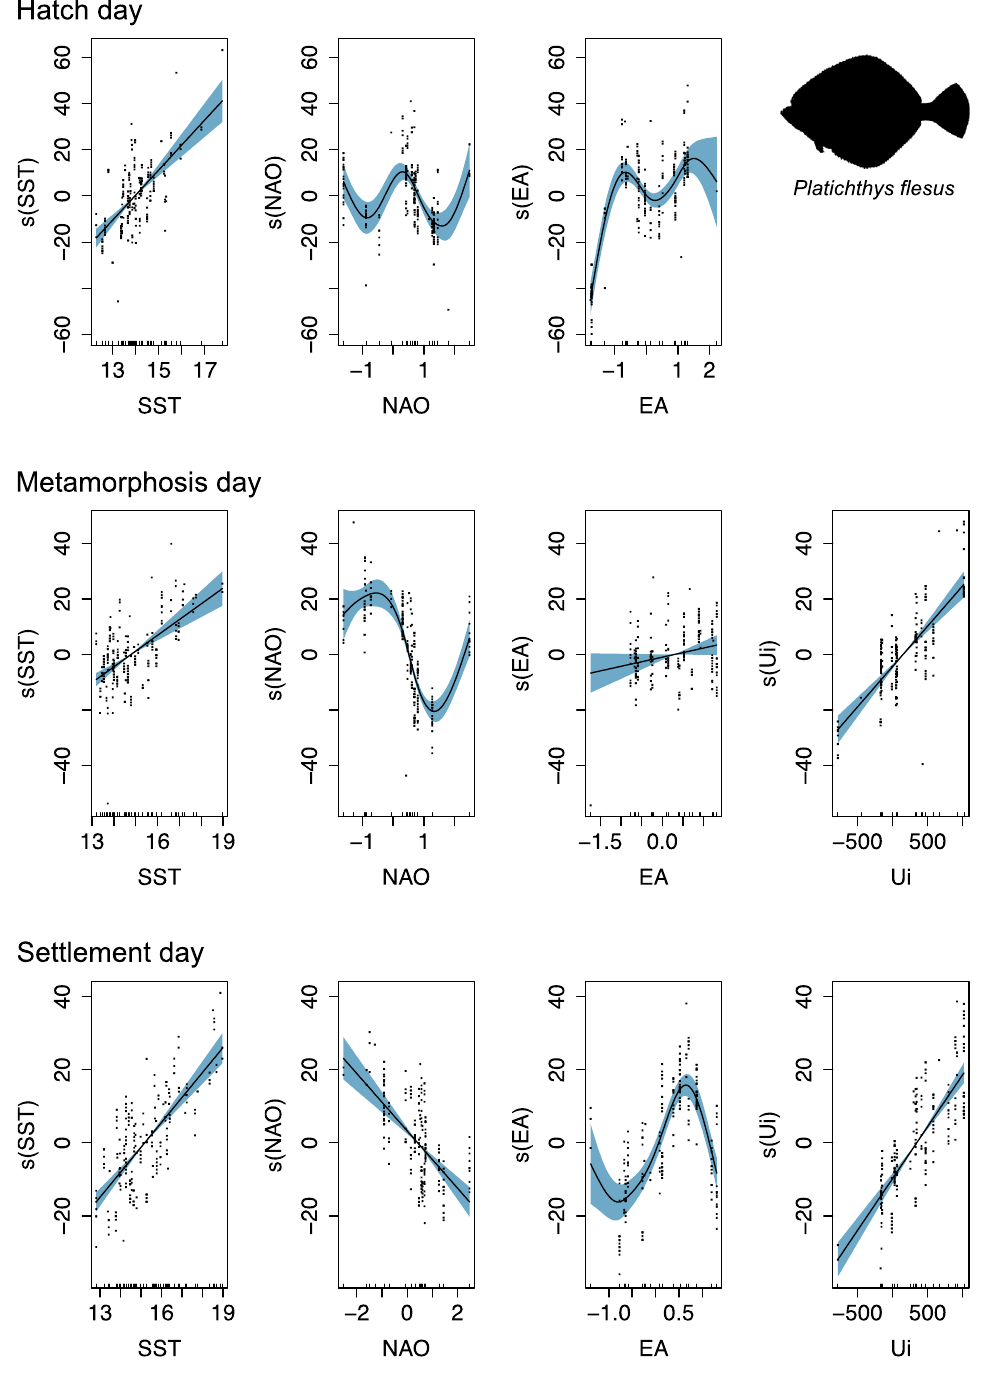
Figure 6. Generalized Additive Models (GAM) smoother response curves of the environmental drivers explaining the variation in Platichthys flesus hatch, metamorphosis, and settlement day for the period between 2010 and 2015. SST—Sea Surface Temperature (°C); Ui—Upwelling index (m 3 s −1 km −1 ); NAO—North Atlantic Oscillation; EA—Eastern Atlantic Pattern. Black dots depict the partial residuals for each term. The uncertainty bands denote the 95% confidence intervals for each